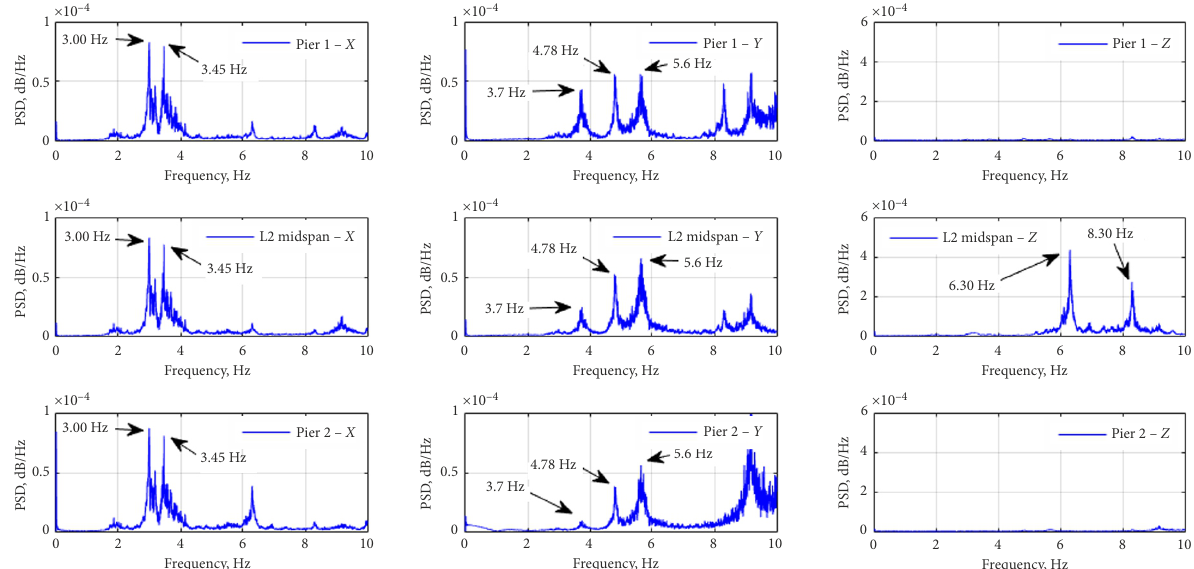
Figure 13. Frequency domain presentation of the signals for the second set of measurements in the second Ambient Vibration Survey